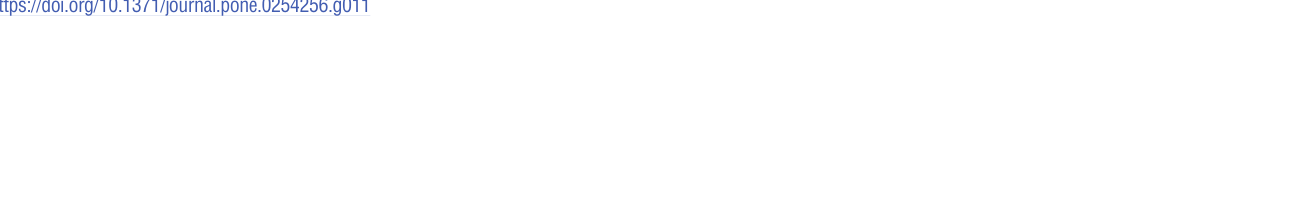
PLOS ONE | https://doi.org/10.1371/journal.pone.0254256 July 8,